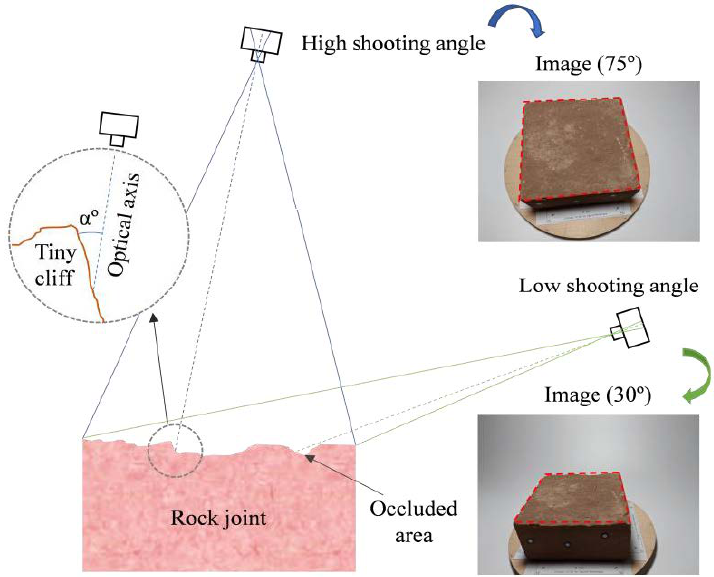
Figure 14. The influence of the camera shooting angle on the reconstruction of rock joint